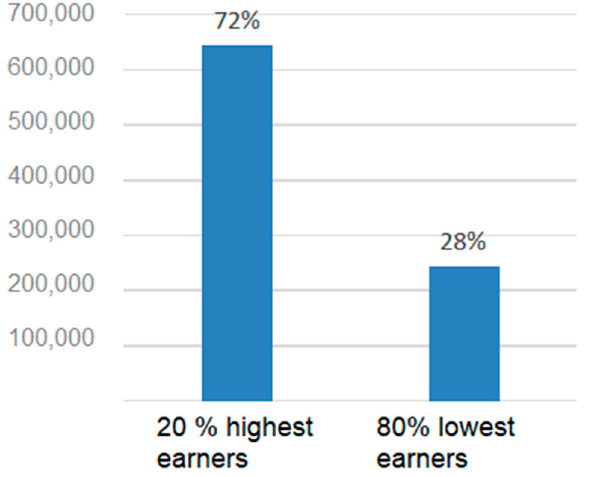
Figure 1. Revenue distribution in REC among businesses in the period.